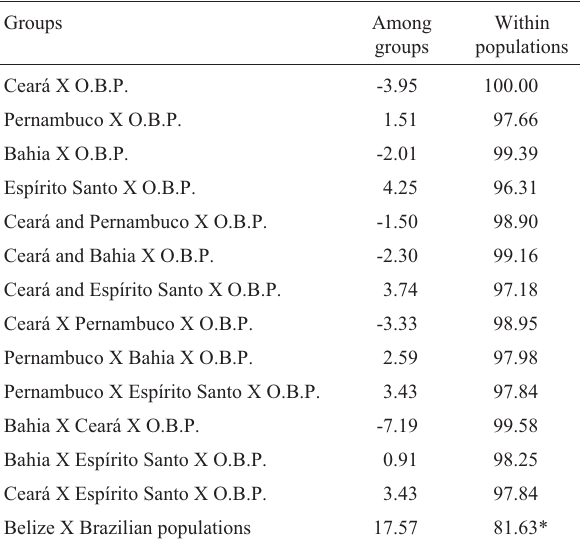
Table 6 - Results of the analysis of molecular variance (AMOVA) from mtDNA sequence data of the Brazilian populations. O.B.P. = Other Bra- zilian Populations. *p <